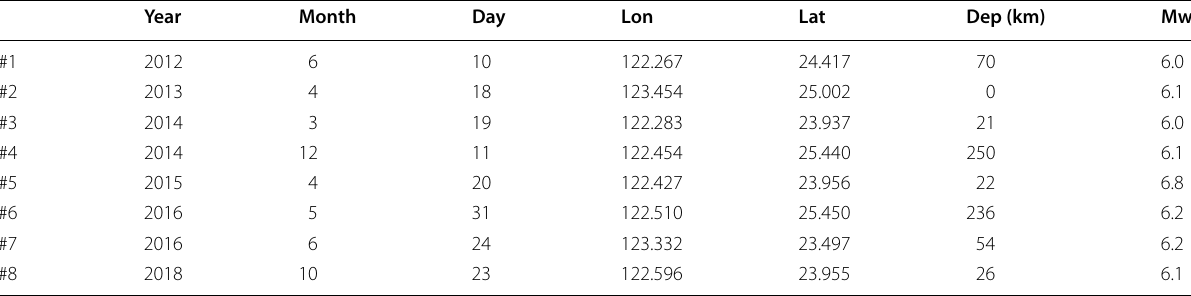
Table 1 List of earthquakes considered in the analysis of the GNSS